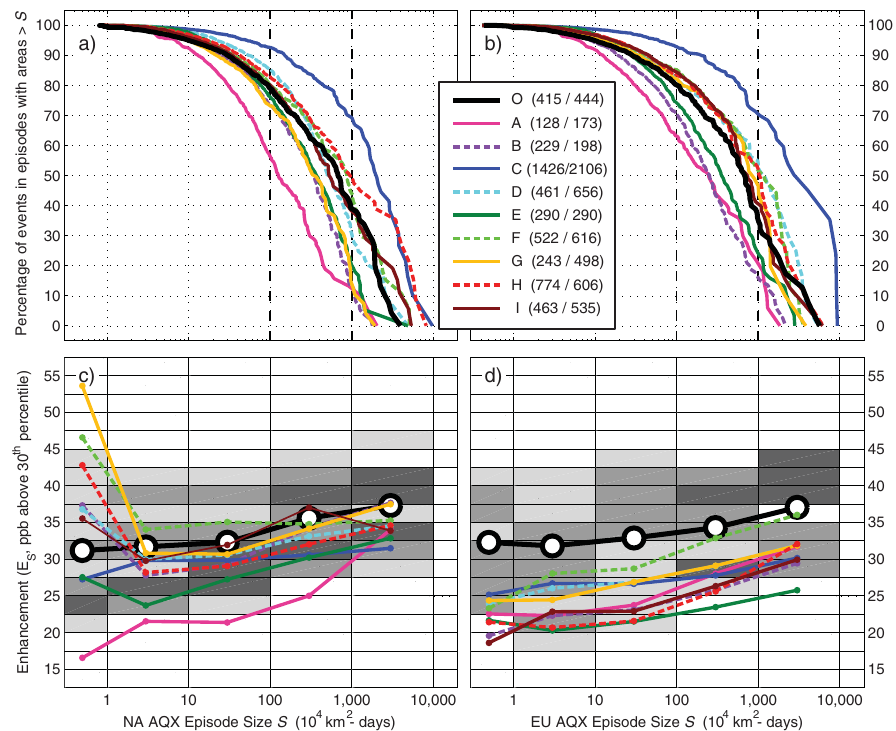
Figure 4. (a–b) Complementary cumulative distribution (CCD) of the percentage of total areal extent of all individual AQX events (100- per-decade case) as a function of AQX episode size ( S , 10 4 km 2 days) for the observations (O), ACCMIP models (A–H), and UCI CTM (I) in (a) NA and ( b ) EU. Dashed vertical lines show the graphical representations of CCD 100 and CCD 1000 . Mean episode size ( S ) for each data set and domain is given in the legend as (NA/EU). (c–d) Density scatterplot of the observations enhancement of AQX episodes E S vs. their size S ( E S binned at 2.5ppb increments from <15ppb to >55ppb, S binned at each log decade) in ( c ) NA and ( d ) EU. The gray scale represents the relative percentage of AQX episodes in each ( x , y ) = ( S , E S ) bin and includes percent ranges of ≤ 5% (white), 5–10, 10–15, and >15% (darkest gray) where the size bins (i.e., columns) are normalized to sum to 100%. The overlain curves show the observation’s and each model’s area-weighted mean enhancement E S for each size bin. The values of E S in each size bin for models A and I have been scaled by 0.5 since they are largely outside the range of the